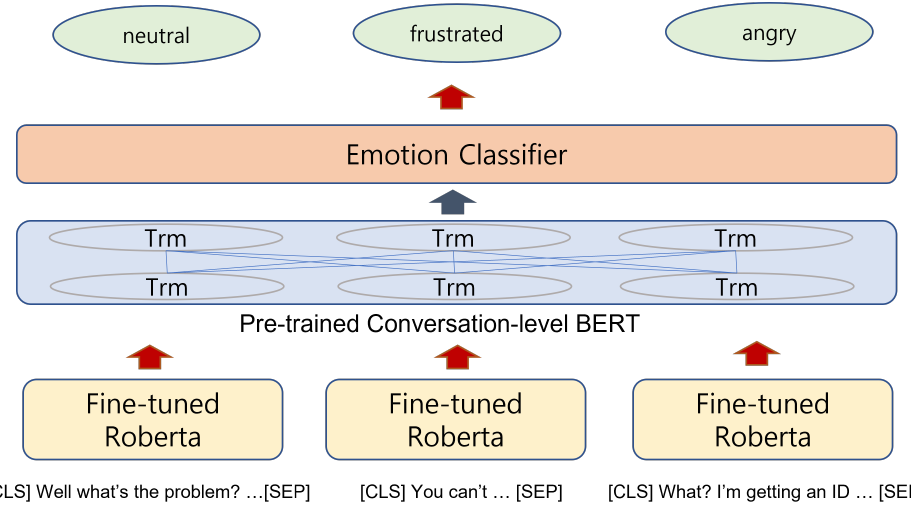
Figure 9. Overview of the ERC model.